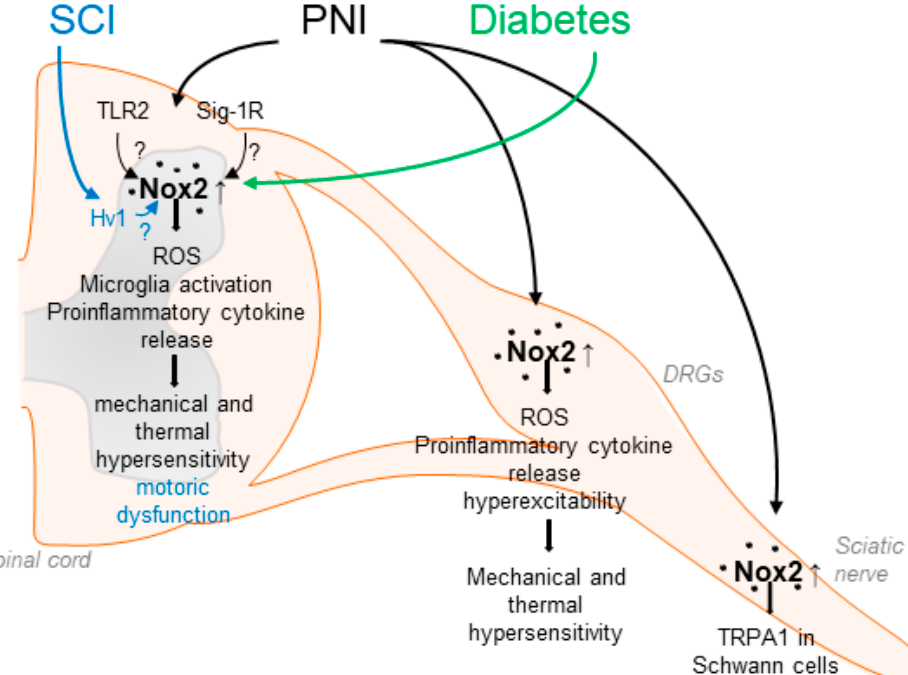
Figure 1. Suggested contributions of Nox2 to pain processing in response to peripheral nerve injury (PNI), spinal cord injury (SCI) and diabetic neuropathy. Nox2 activity is increased in the spinal cord, DRGs and the sciatic nerve after up-regulation of Nox2 expression in microglial cells or through recruitment of Nox2-positive macrophages. This leads for example to enhanced ROS production and enhanced release of proinflammatory cytokines, resulting in enhanced mechanical and thermal hypersensitivity. Activation of Nox2 in response to PNI has been suggested to be mediated by TLR2 and Sig-1R. In addition, SCI and diabetic conditions also lead to enhanced Nox2 expression and activity in the spinal